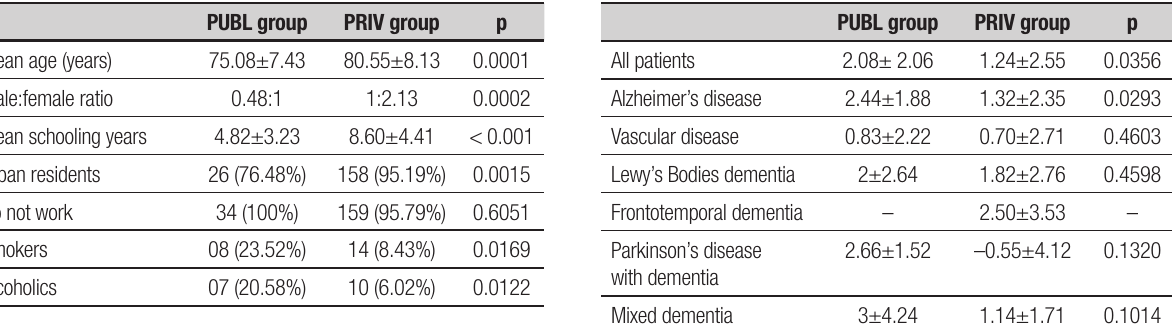
Table 1. Epidemiological and sociocultural data of patients with dementia. Table 2. Mean years elapsed until treatment.